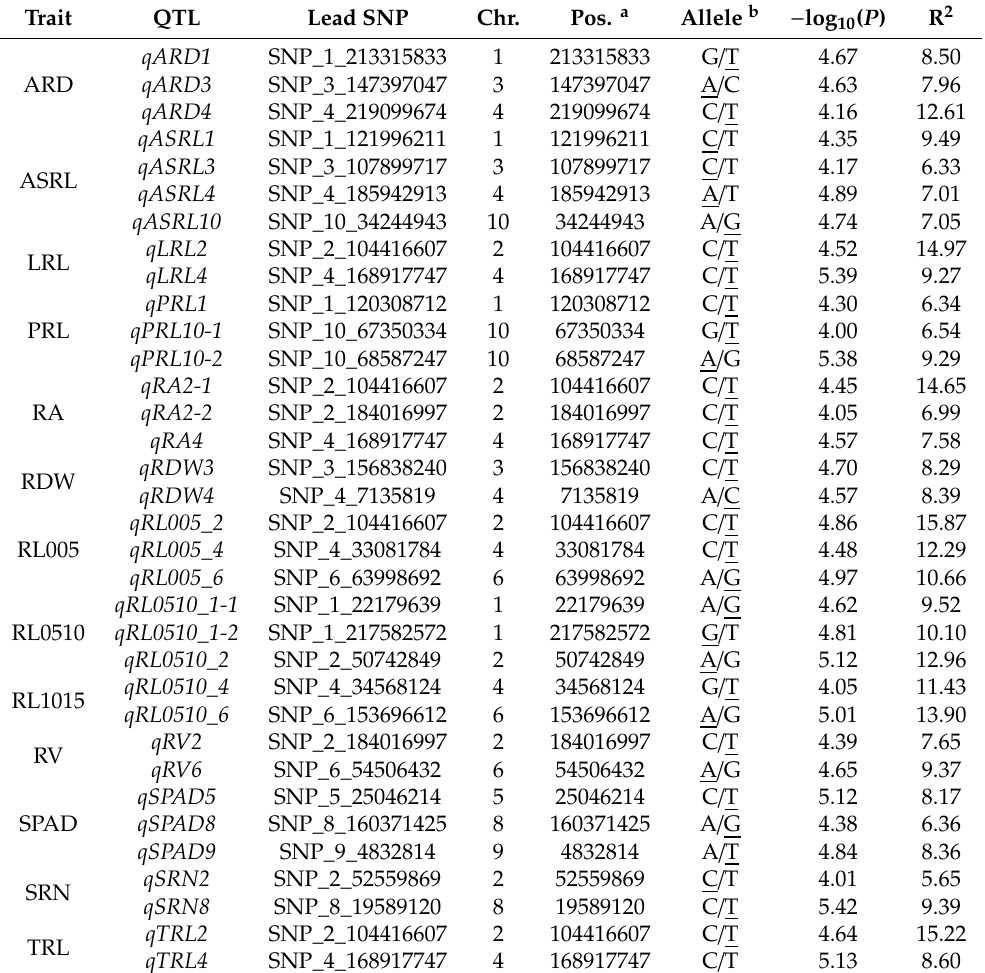
Table 3. QTLs significantly associated with root traits detected by